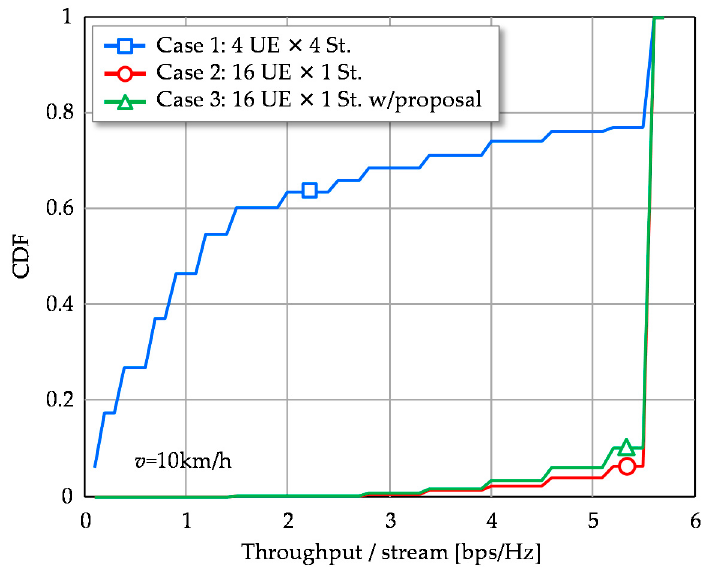
Figure 6. CDFs of throughput per signal stream.